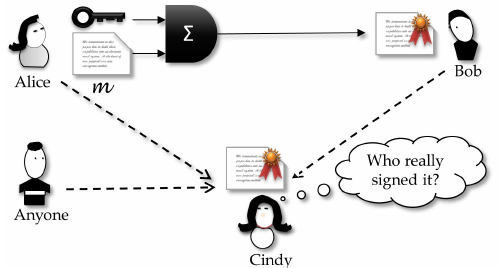
Figure 5. In SDVS, a curious Cindy cannot decide who is the author of the signature, because this one is indistinguishable from any other that anybody could